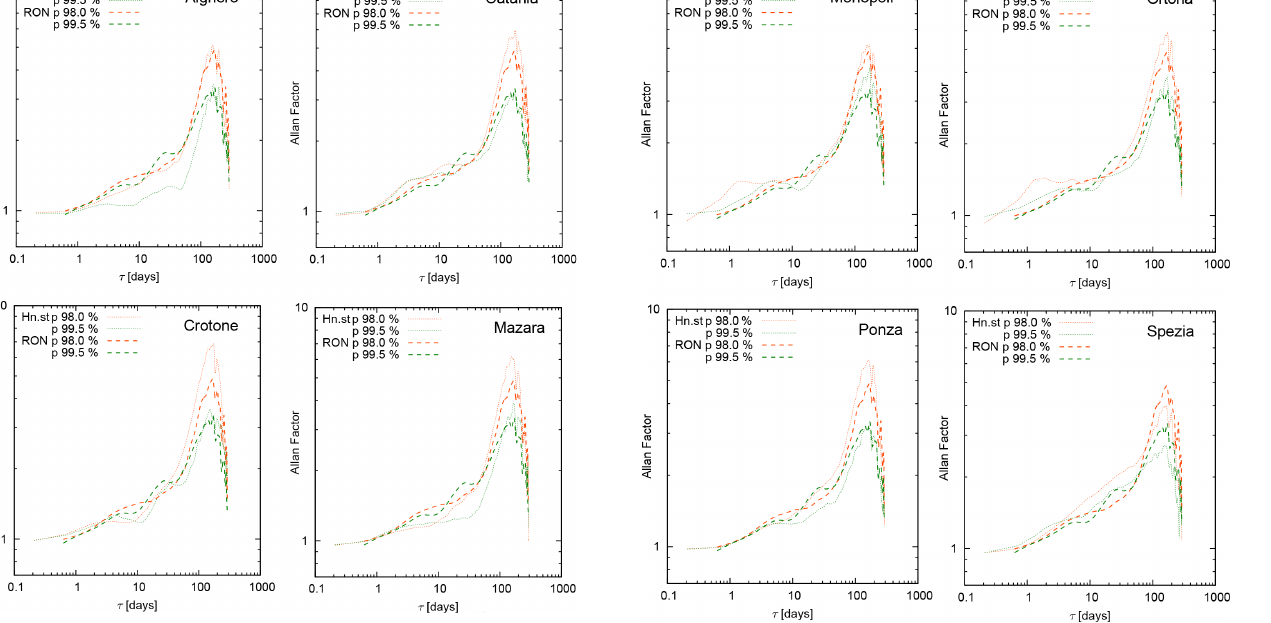
Figure 6. Comparison of Allan factor between RON and hindcast data series for different threshold percentiles (98 and